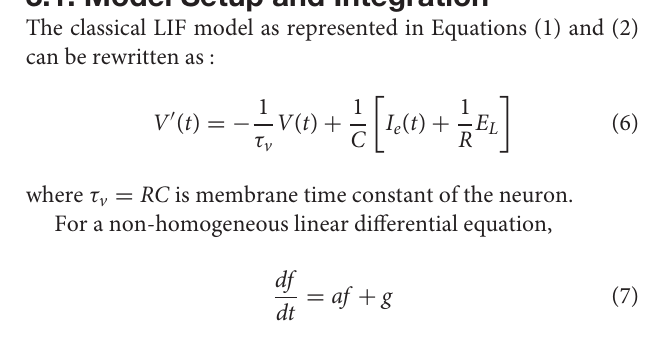
model based on two internal state variables : the synaptic current and the membrane potential (Davies et al.,